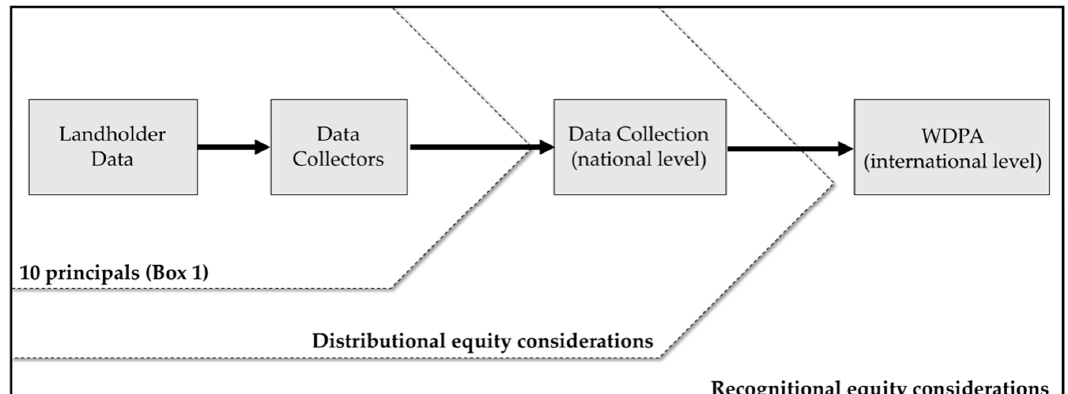
Figure 1. Conceptual flow of privately protected area (PPA) data from local (landholder) to international (World Database on Protected Areas; WDPA) reporting levels. Recognitional equity considerations are important at all levels, while distributional and procedural equity considerations are most applicable to the PPA data collection and collation decisions, rules, and responsibilities established within a country (Table 1). The ten principles described in Box 1 are intended to guide equitable data collection by the local, state, or regional organizations that oversee the PPA agreements.